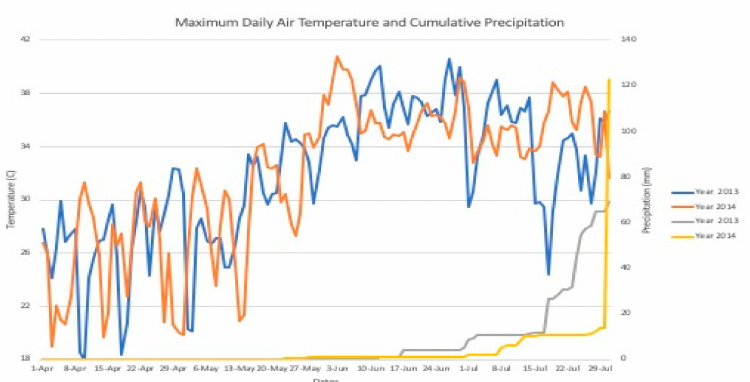
Figure 2. Maximum daily air temperature (degree C) and cumulative precipitation (mm) at Leyen- decker Plant Science Research Center in Las Cruces, New Mexico, USA, from April through July of 2013 and